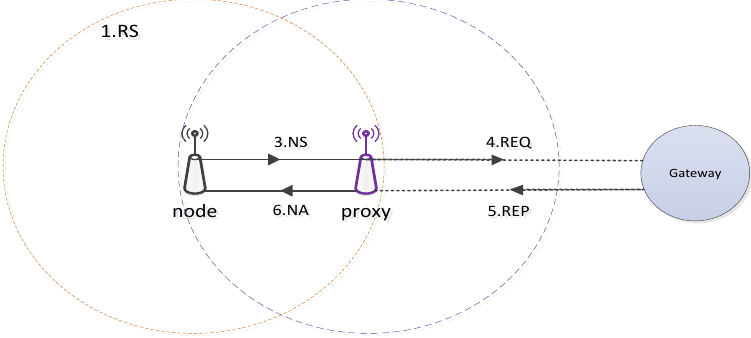
Figure 3. Processes of allocating IP addresses through a proxy node.